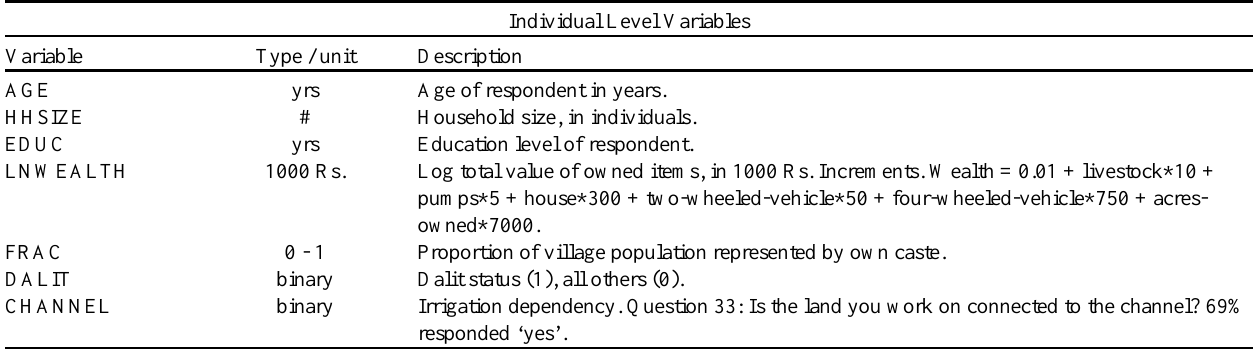
Table 3. Description of individual and village-level predictor and control variables. Variables of theoretical interest include DALIT, FRAC, and CASTES. Other variables are included for statistical